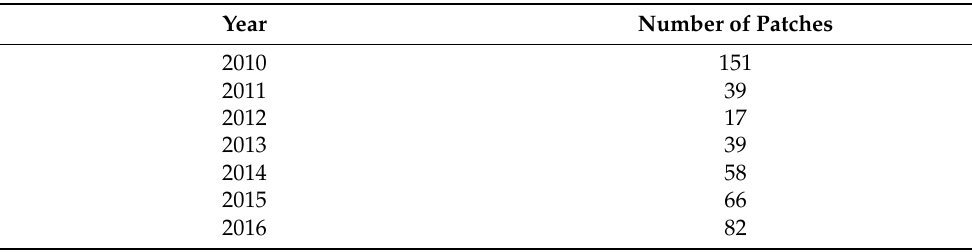
Table 3. Summary of alligator weed patches identified and digitised between 2010 and 2016 in the study area.